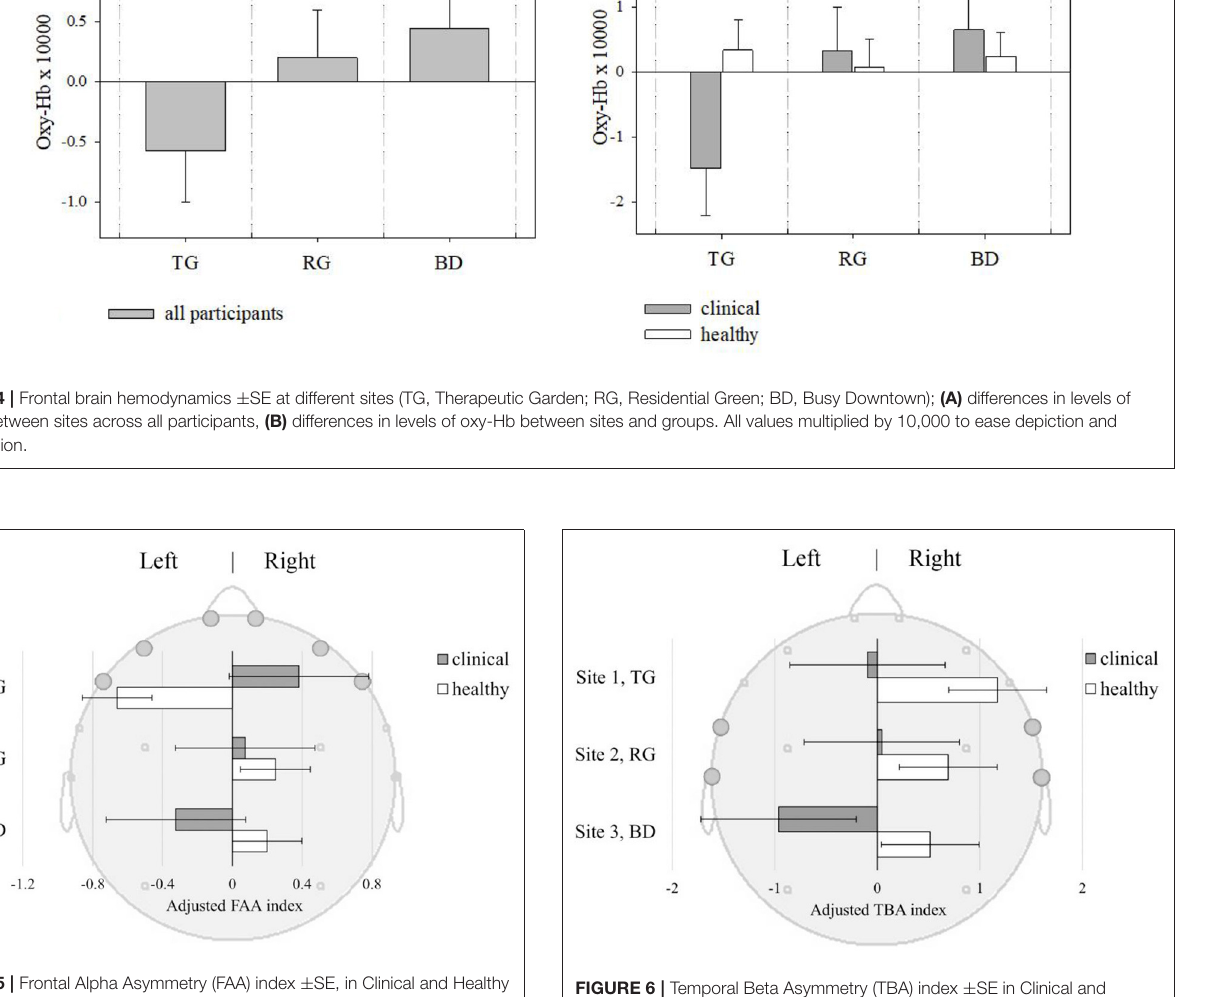
FIGURE 6 | Temporal Beta Asymmetry (TBA) index ± SE in Clinical and Healthy samples at three sites: TG, Therapeutic Garden; RG, Residential Green; BD, Busy Downtown. TBA index [(R-L)/(R + L)] was derived from baseline-corrected power density values from the left (FT7 + T7) and right (FT8 + T8) temporal